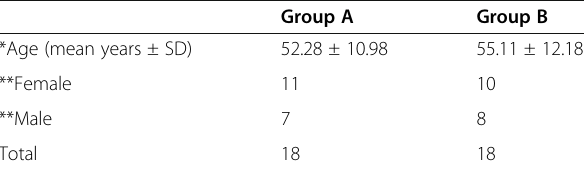
Table 1 Patient demographics by treatment group: 7 year follow-up